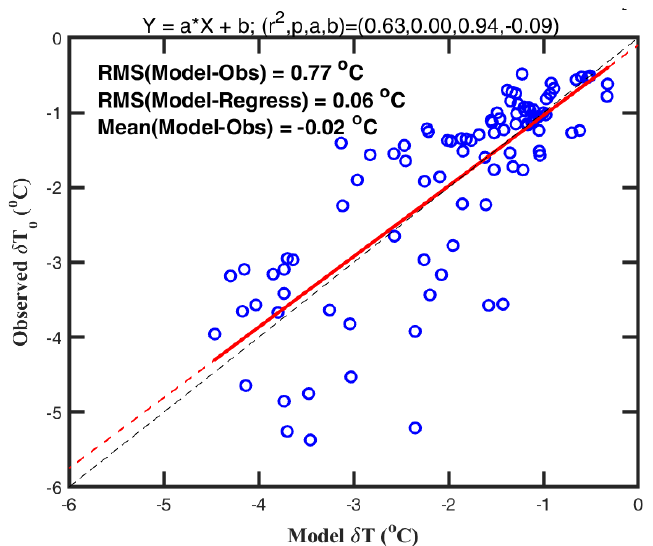
Figure 4. A plot of observed cooling δ T O (Y ‐ axis) vs. modelled cooling δ T (X ‐ axis). The regression line is red and reference “perfect” line is black. Title shows the best ‐ fit regression equation with coefficients a and b, % of explained variance r 2 , and p -value (<10 − 3 ). Inset prints the rms model − observed difference, rms model’s departure from the regression line, and the mean model − observed difference. This plot uses h 2 = <h 2 > = 80.6 m (Table